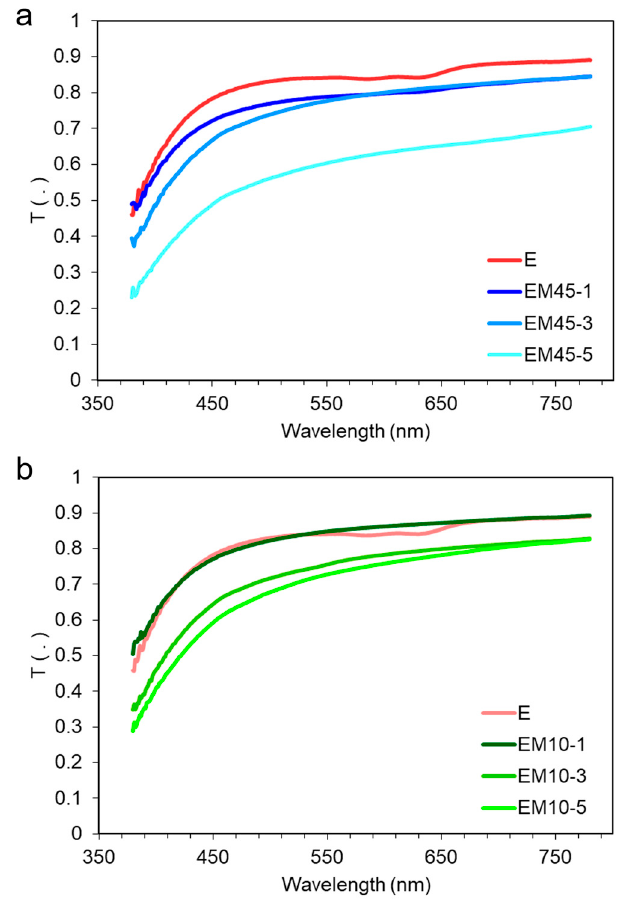
Figure 8. Measured spectral transmittance of ( a ) the samples with different fractions of Mica 10 and ( b ) the samples with different fractions of Mica 45.